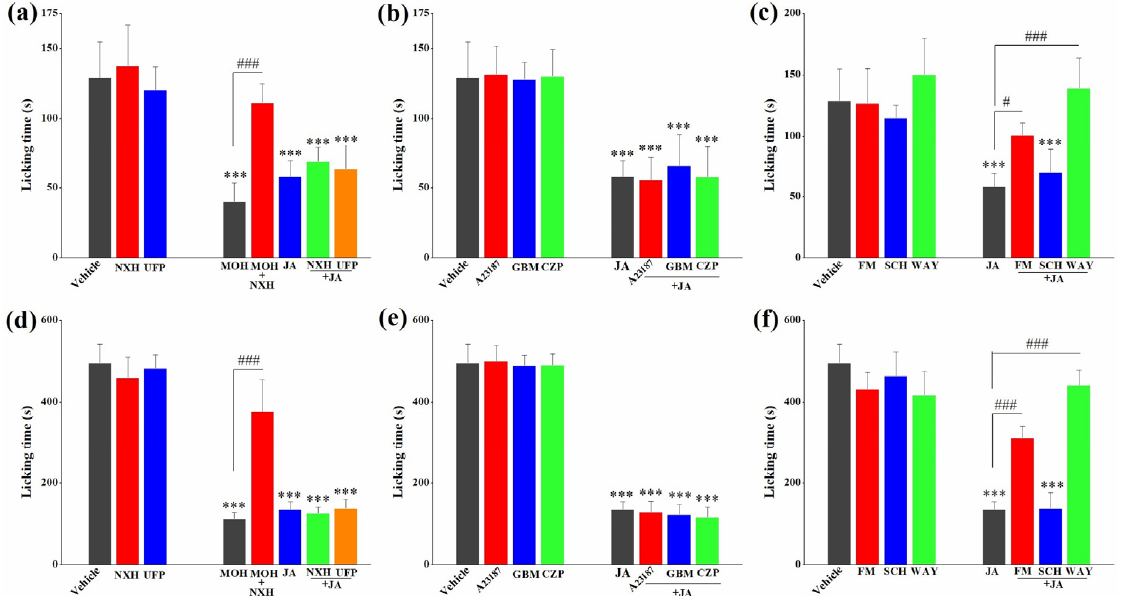
Figure 6. Effect of antagonists in the opioid system ( a , d ), antagonists and calcium ionophore in the ion channels system ( b , e ) and antagonists in the neurotransmitters system ( c , f ) on the antinociceptive activity of jegosaponin A (JA) in phase 1 ( a – c ) and phase 2 ( d – f ) of the formalin test. Vehicle: blank control, MOH: morphine hydrochloride. UFP: UFP-101, GBM: glibenclamide, CZP: capsazepine, FM: flumazenil, SCH: SCH23390 and WAY: WAY100635. Data are displayed as mean ± SD. *** p < 0.001 vs. vehicle group. # p < 0.05, ### p < 0.001 vs. model group.